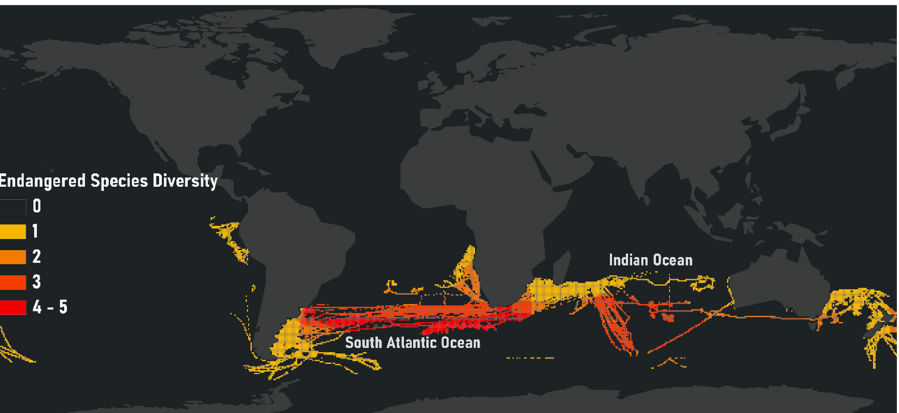
Figure 5. Endangered albatross species’ diversity within FOC longliner Areas. FOC longliners were present in 46,165 grid cells of the 159,087 at-sea grid cells in 2016. Of these 46,165 grid cells, 18% (8483 grid cells) overlapped with the ranges of at least one threatened albatross species. Such at-risk areas for IUU fishing should be the focus of prevention and bycatch mitigation strategies to reduce the mortality rates of protected albatross